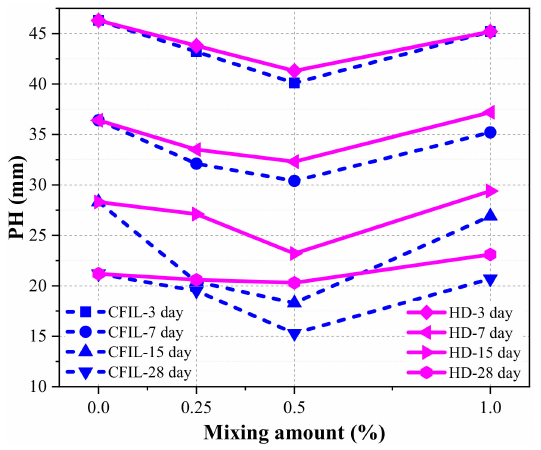
Figure 18. Relationship between PH and the mixing